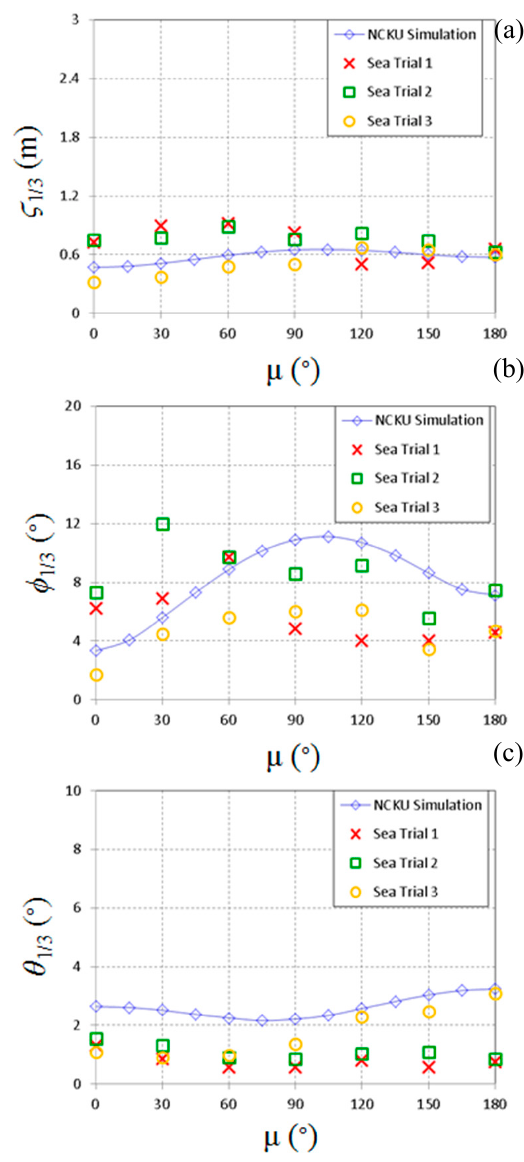
Figure 3. Comparison of results for the simulation and on-board measurement in terms of ( a ) heaving, ( b ) rolling, and ( c ) pitching motion at low sailing speed.